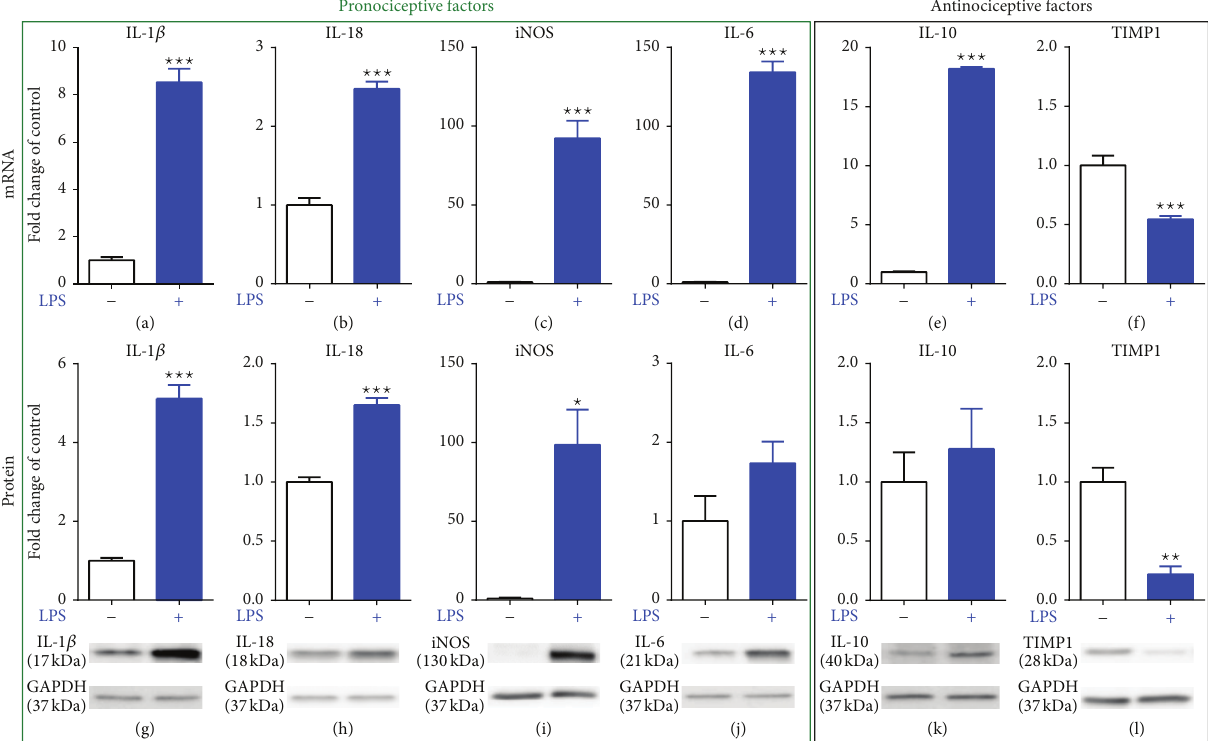
Figure 5: Effects of LPS on the mRNA and protein level of pronociceptive (IL-1 𝛽 , IL-18, IL-6, and iNOS) and antinociceptive (IL-10 and TIMP1) factors in the primary rat microglial cell cultures. Samples were analyzed 24 hours after stimulation of cells with LPS. Upregulation of mRNA for IL-1 𝛽 (a), IL-18 (b), iNOS (c), IL-6 (d), IL-10 (e), and downregulation of mRNA for TIMP1 (f) were observed after LPS treatment. The protein level of IL-1 𝛽 (g), IL-18 (h), and iNOS (i) were significantly upregulated and of TIMP1 (l) was downregulated after LPS stimulation. Protein level of IL-6 and IL-10 remained unchanged after LPS administration. The qRT-PCR and Western blot data are presented as the mean ± SEM and represent the normalized averages derived from analyses of 3–10 samples for each group. Statistical analysis was performed using 𝑡 test, ∗ 𝑃 < 0.05 , ∗∗ 𝑃 < 0.01 , and ∗∗∗ 𝑃 < 0.001 indicate significant differences compared to vehicle-treated cells. LPS: lipopolysaccharide. The immunoblots shown are representative of 3–5 individual